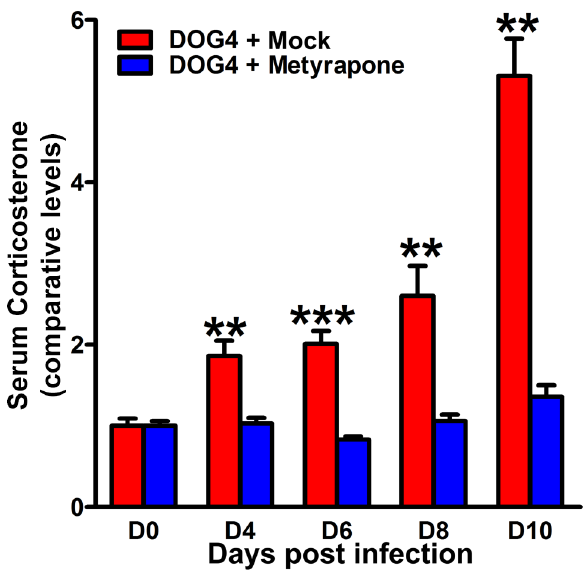
Figure 6. Post-exposure treatment of DOG4 RV-infected mice with metyrapone blocks the rise in corticosterone associated with pathogenic RABV. Mice were infected with 10 4 FFU of DOG4 RABV i.n. and either mock treated with PBS or treated with metyrapone (100 mg/kg) i.p. each day for 21 days. Ten mice per group were bled 1 hr after injection for each time point. The results represent comparative levels of corticosterone ( + / 2 SE). *p , .05, **p , .01, and ***p , .001, respectively.